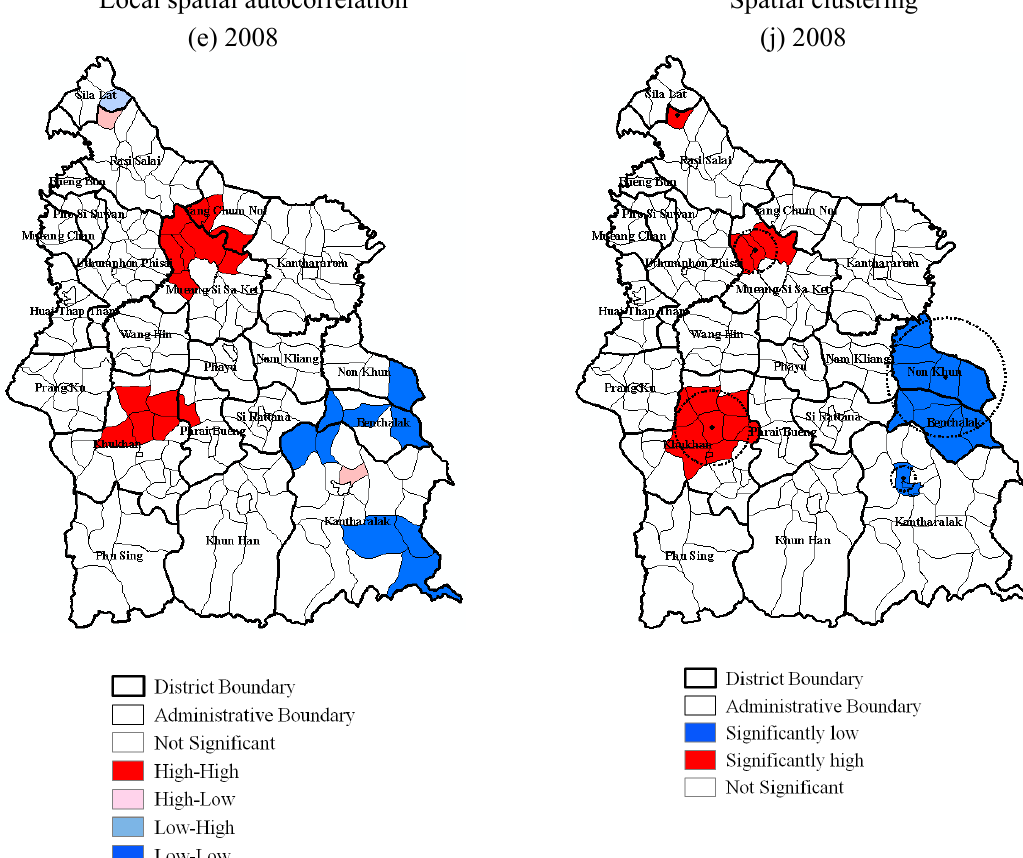
Figure 5. Local spatial pattern of TB incidence in Si Sa Ket from 2004 to 2008.